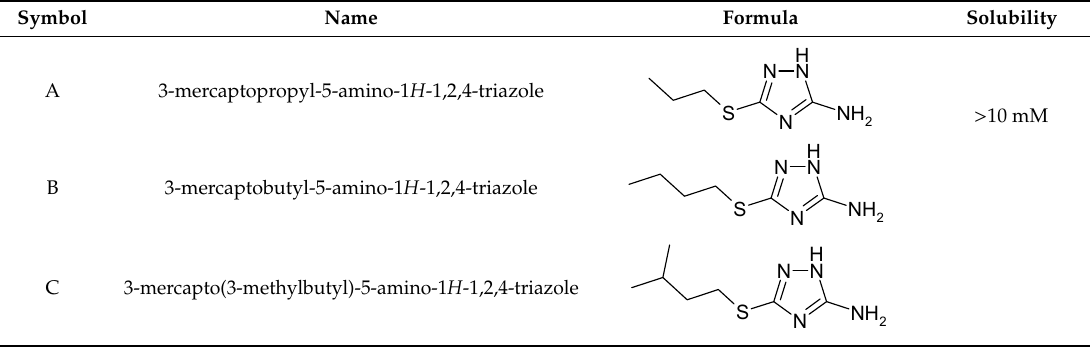
Table 1. Inhibitor names, structures and solubility in water.